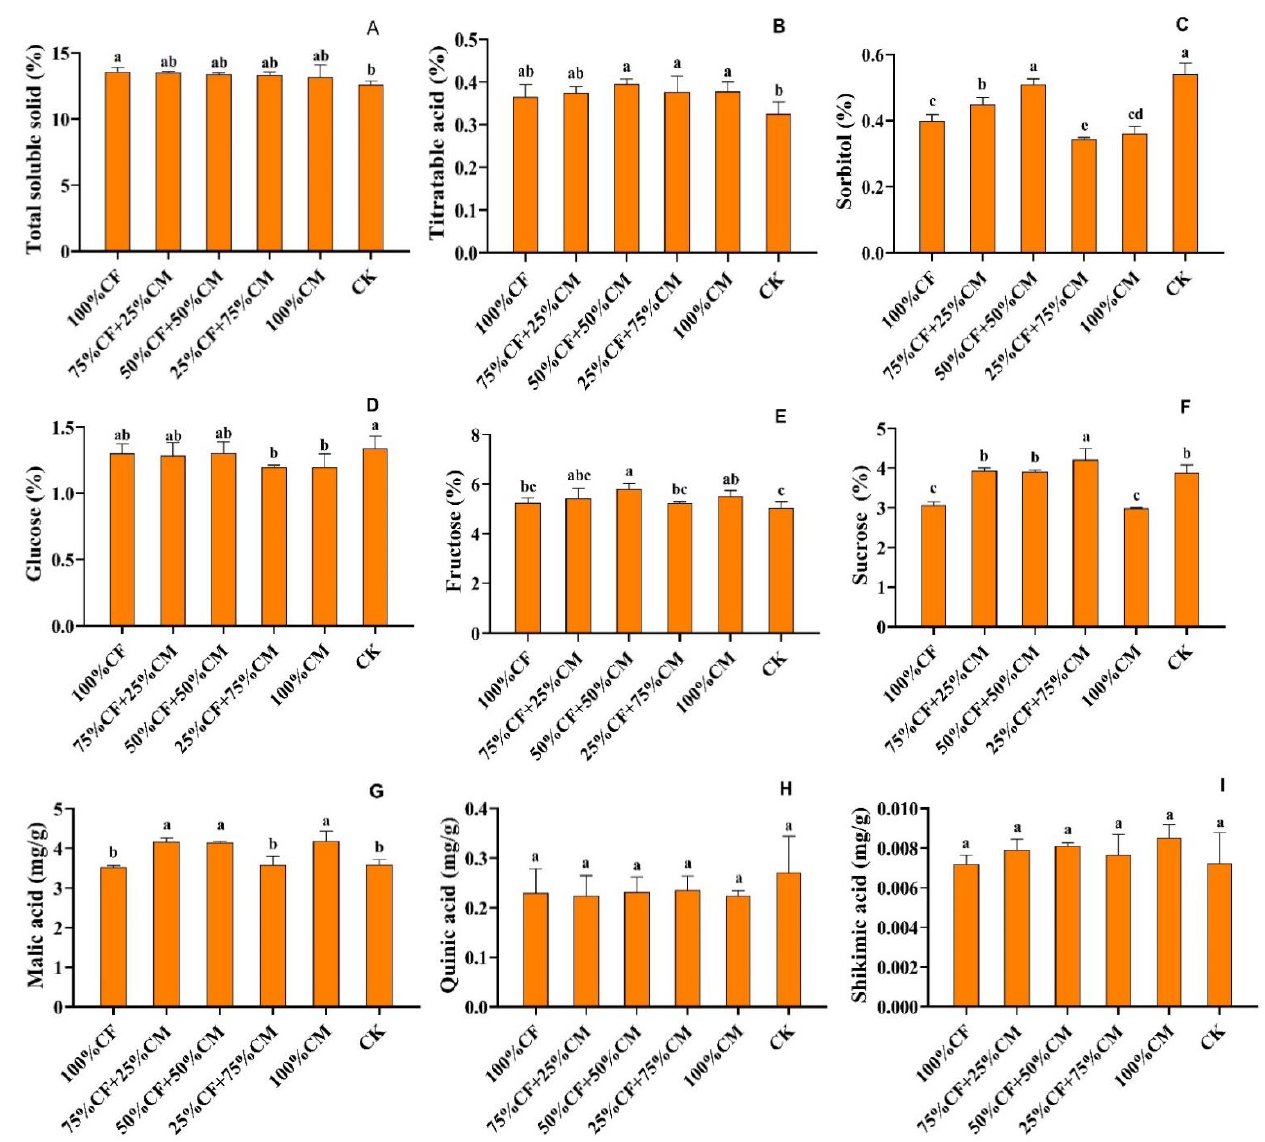
Figure 1. Effect of different ratios of cow manure and chemical fertilizers on total soluble solids, titratable acid, sugar-acid fraction of fruits: ( A ) total soluble solid; ( B ) titratable acid ( C ) sorbitol; ( D ) glucose; ( E ) fructose; ( F ) sucrose; ( G ) malic acid; ( H ) quinic acid; ( I ) shikimic acid. Different lowercase letters indicate significant differences between treatments ( p < 0.05) .